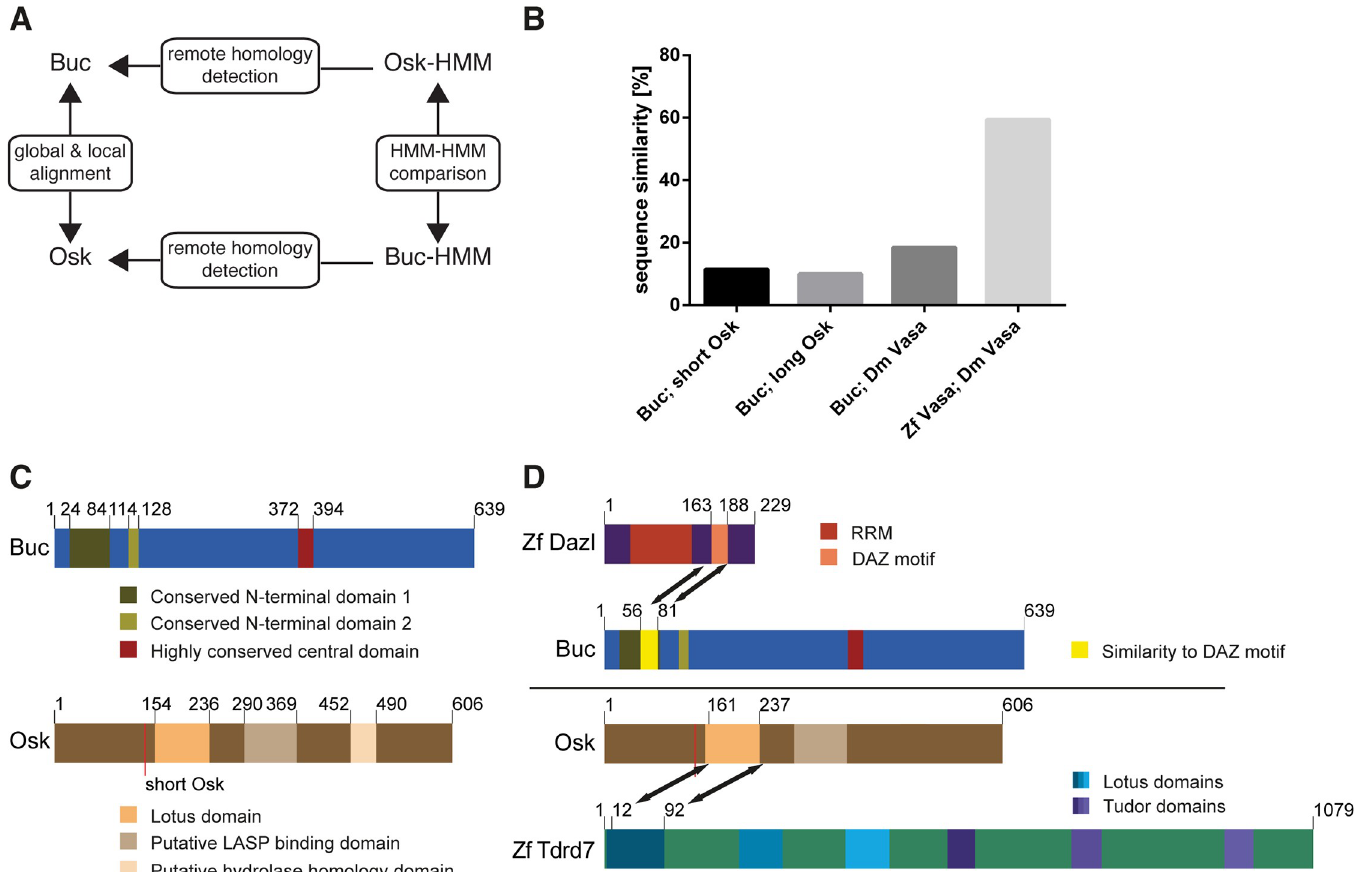
Fig 3. Drosophila Osk and zebrafish Buc display unrelated protein sequences. (A) Strategy for Osk-Buc sequence comparison using first global and local alignment algorithms, then hidden Markov models (HMM) of both proteins to detect remote homologies, and eventually a comparison of HMM to each other. (B) Graph comparing sequence similarity of Buc with short (aa139-606) and long Osk (aa1-606) isoforms based on global pairwise sequence alignments. Alignment of Buc and Drosophila Vasa (Dm Vasa) serves as negative, whereas zebrafish (Zf Vasa) and Dm Vasa as positive control. (C) Scheme of conserved domains in Buc identified by alignments of 14 protein sequences. Conserved motifs in Osk protein. Red line indicates alternative translation initiation of short Osk at Met139. (D) Scheme indicating significant remote sequence similarity based on HMMER analysis for Buc with zebrafish Dazl and for Osk with the Lotus domain of zebrafish Tdrd7. Numbers indicate amino acid